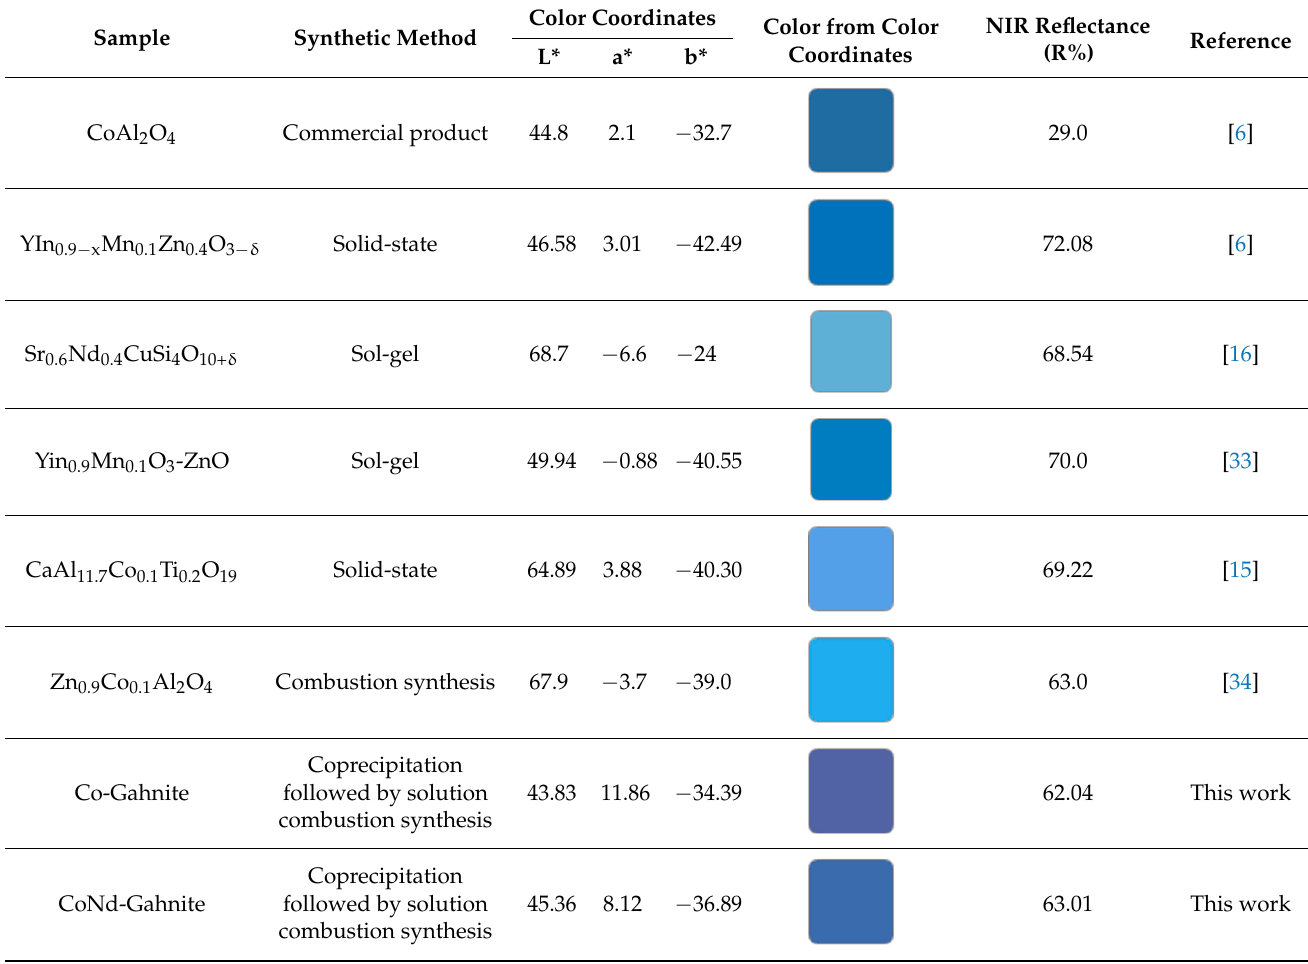
Figure 6 . ( a ) Diffuse reflectance spectra of the synthesized pigments in powder form, and ( b ) NIR solar reflectance spectrum of the powder pigments adjusted to the standard solar spectrum. Table 2. Color Coordinates and NIR Reflectivity of Co-Gahnite, CoNd-Gahnite, and other blue pigments with the synthesis method employed.